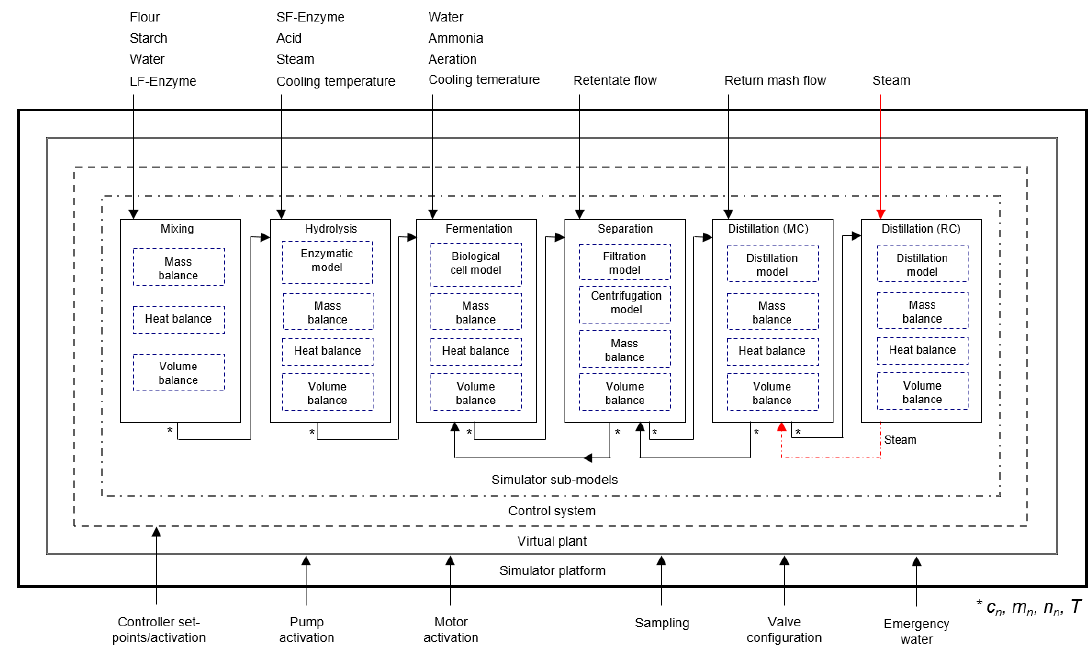
Figure 3. Simplified scheme of the modelling framework of the virtual bioethanol plant showing the structure of the OTS where the plant, the control system and the simulator sub-window are implemented as an interacting system in the simulator platform (WinErs). Inputs defined by the trainee such as mass flow for flour, flow rate for enzyme solutions or the retentate flow are transferred to the mixing (pre-treatment), hydrolysis or filtration sub-model, respectively. State variables (*) are computed (e.g., concentration for glucose or ethanol ( c Glc , c EtOH ), and temperature of the broth ( T Ferm )) and are used as inputs for a subsequent sub-model.